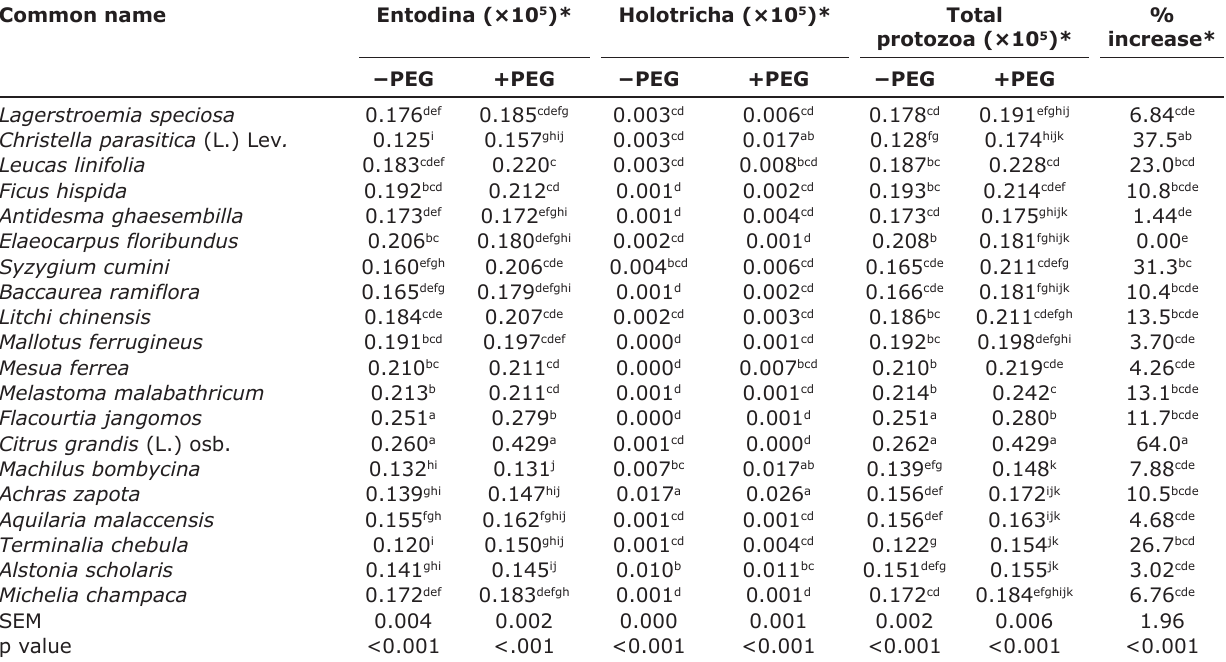
Table-4: Effect of medicinal plant leaves on rumen protozoal population. Common